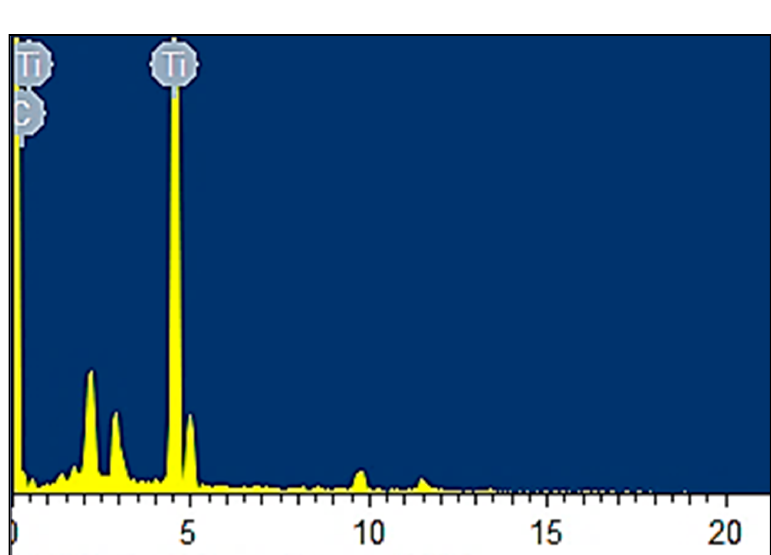
Figure 3. Elemental composition analyzed by energy-dispersive X-ray spectroscopy (EDS) on HDPE/TiO 2 nanocomposite at 5 wt % injection molded under a barrel temperature of 250 °C and residence time of 50 min.